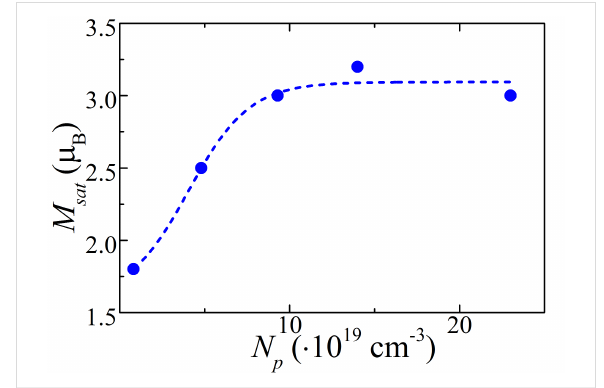
Figure 2: Room-temperature saturation magnetization ( M sat ) as a function of the carrier concentration ( N p ) (the dashed line is a guide to the